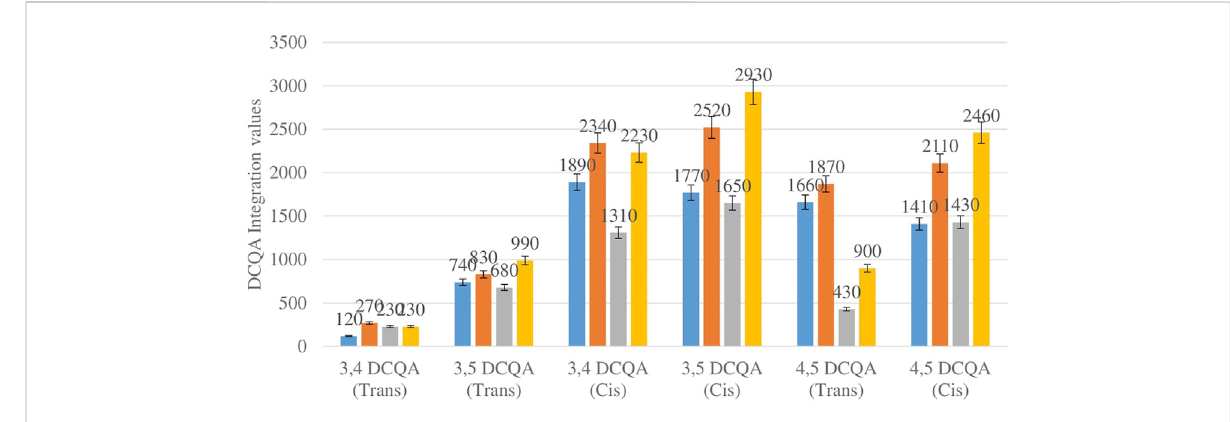
FIGURE 3 DCQA isomers mean concentration comparison between wet sites in each of the two locations in both seasons. Blue-wet site spring (Telperion), Orange-wet site spring (Wake fi eld), Grey-wet site autumn (Telperion), Yellow-wet site autumn (Wake fi